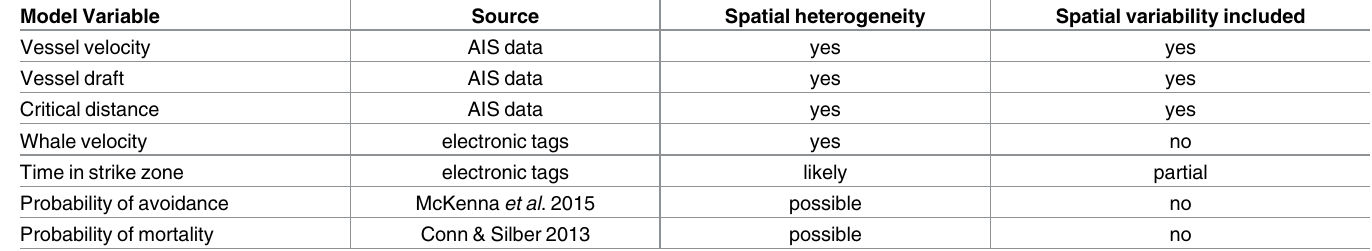
Table 1. Variables used in the strike risk model and their sources. We report the expectedlikelihoodof spatialheterogeneity for each variableand whetherthat variabilitycould be includedin the